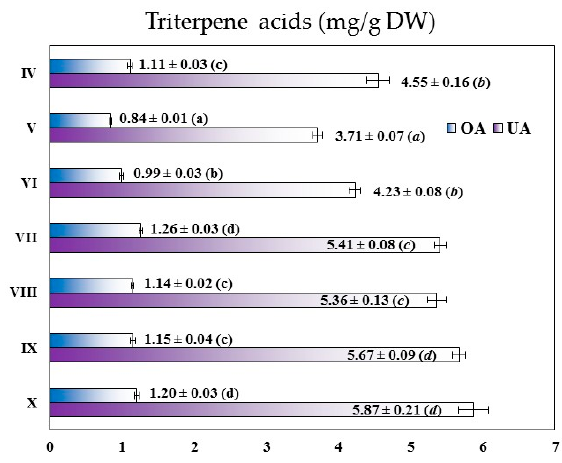
Figure 3. Seasonal variation (IV-X 2014) in the content of oleanolic and ursolic acid in the leaves of G. procumbens . Results are presented as mean values calculated per dry weight of the plant material ± SD ( n = 3 × 3) represented by error bars, different superscripts (a–d) indicate significant differences in the mean values at p < 0.05 by the Tukey’s test; abbreviations: OA , oleanolic acid; UA , ursolic